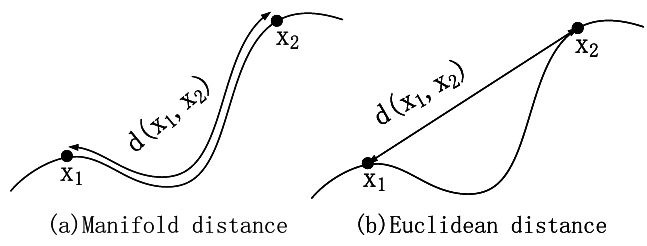
Figure 10. Difference of Manifold distance and Euclidean